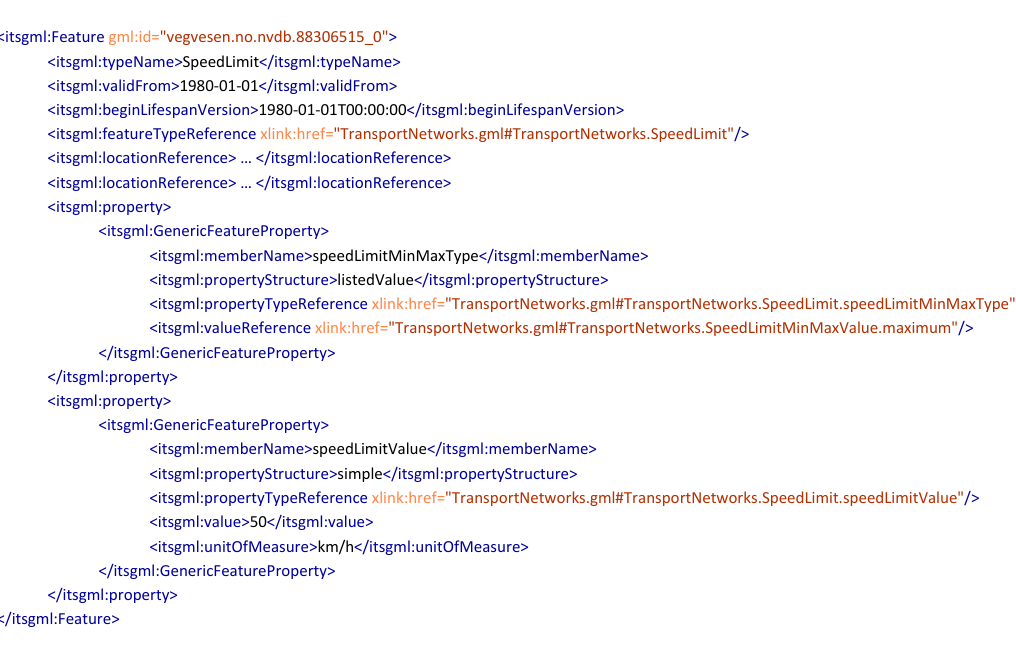
Figure 12. Extract of the INSPIRE TN Feature Exchange GML file with an instance of a SpeedLimit feature type.